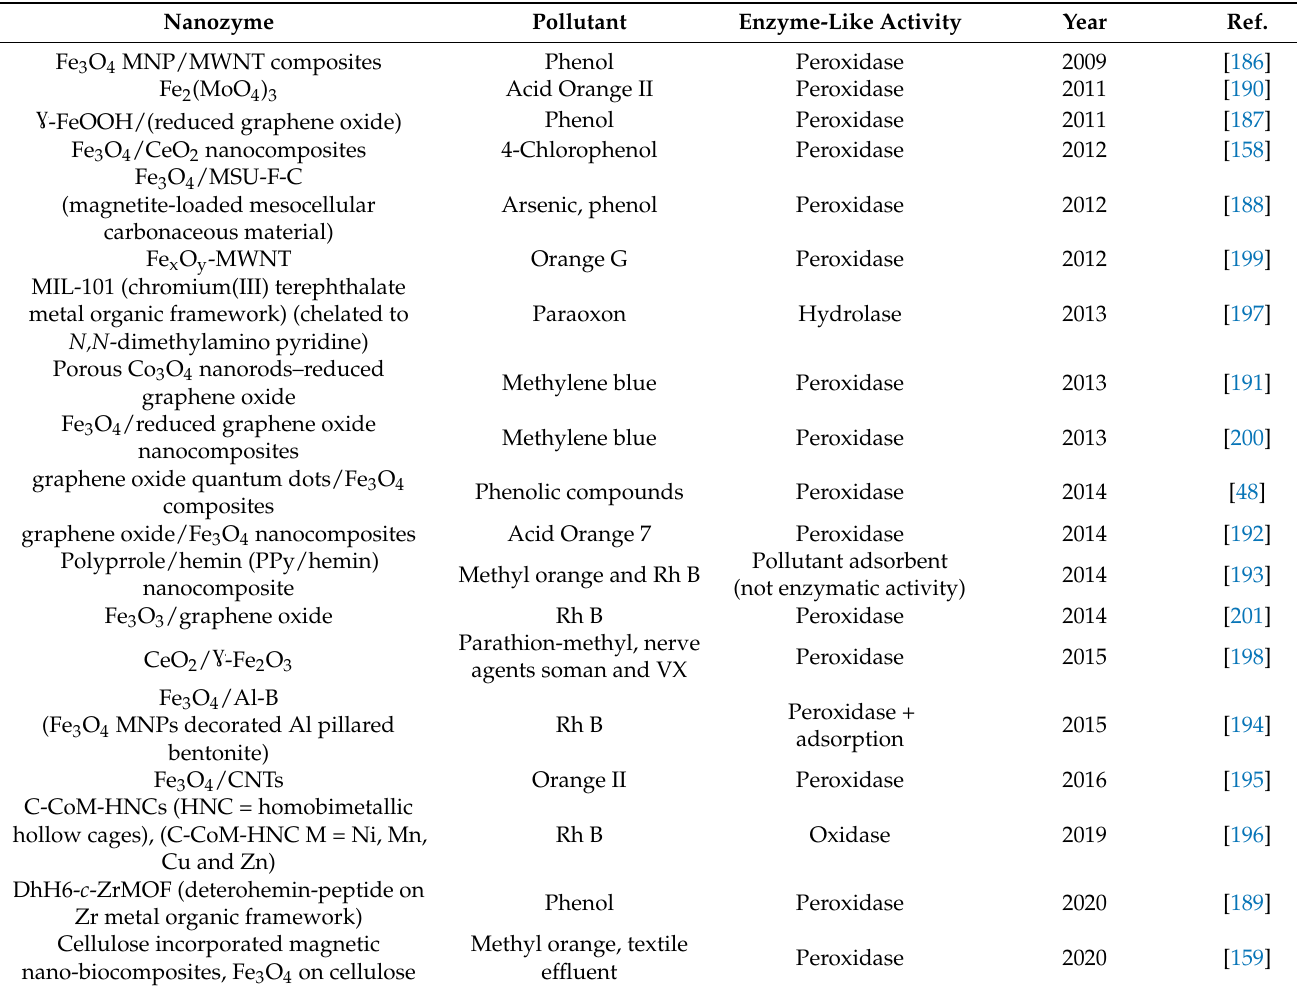
Table 5. Examples of type III nanozymes in environmental pollutant remediation.